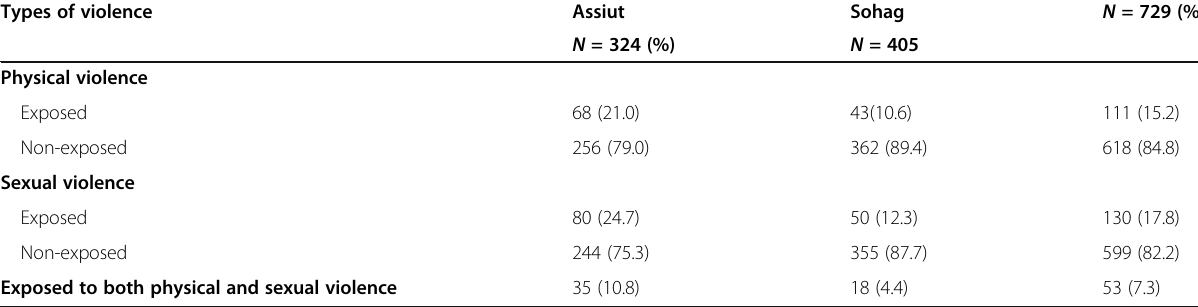
Table 2 Exposure of the married adolescent girls (MAGs) to physical and sexual violence, Upper Egypt Types of violence